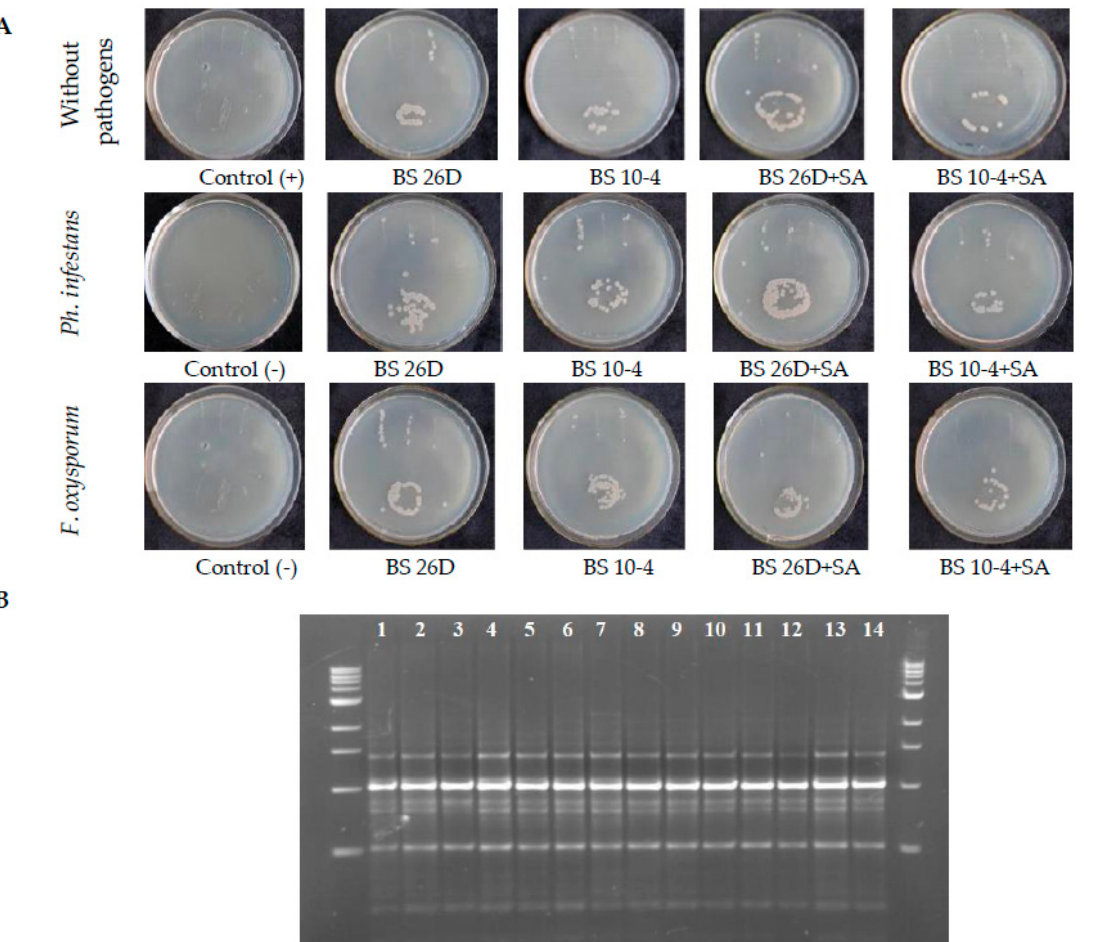
Figure 4. Assessment of the ability of B. subtilis 10-4 (BS 10-4) and 26D (BS 26D) to colonize the internal tissues of potato tubers treated before storing with BS 10-4, 26D and SA under normal and pathogens ( Ph. infestans and F. oxysporum )-infected conditions. A —bacterial growth at the site of imprints of slices of surface-sterilized tubers inoculated with BS 10-4 and 26D before storage (control—the absence of bacterial growth at the site of imprints of sections of surface-sterilized tubers not inoculated with B. subtilis before storing); B —electrophoregram of PAAG after RAPD-PCR analysis: 1 —DNA of the original BS 10-4; 2 —DNA of the original BS 26D; 3 —DNA of the corresponding bacterial strains isolated from the prints of tubers treated with BS 10-4; 4 —DNA of the corresponding bacterial strain isolated from the prints of tubers treated with BS 26D; 5 —BS 10-4 + SA; 6 —BS 26D +